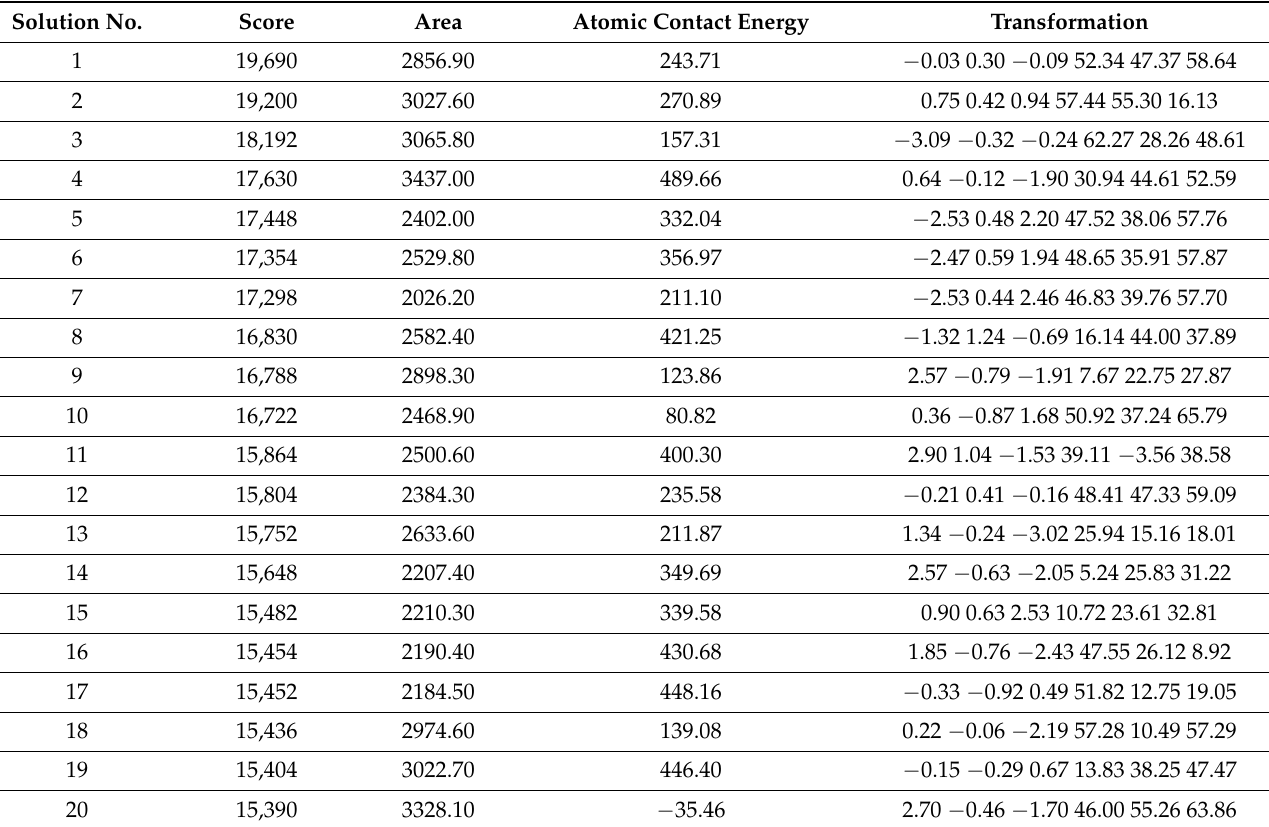
Table 8. Top 20 docking scores of the vaccine and MHC-I, generated by the PATCHDOCK webserver.